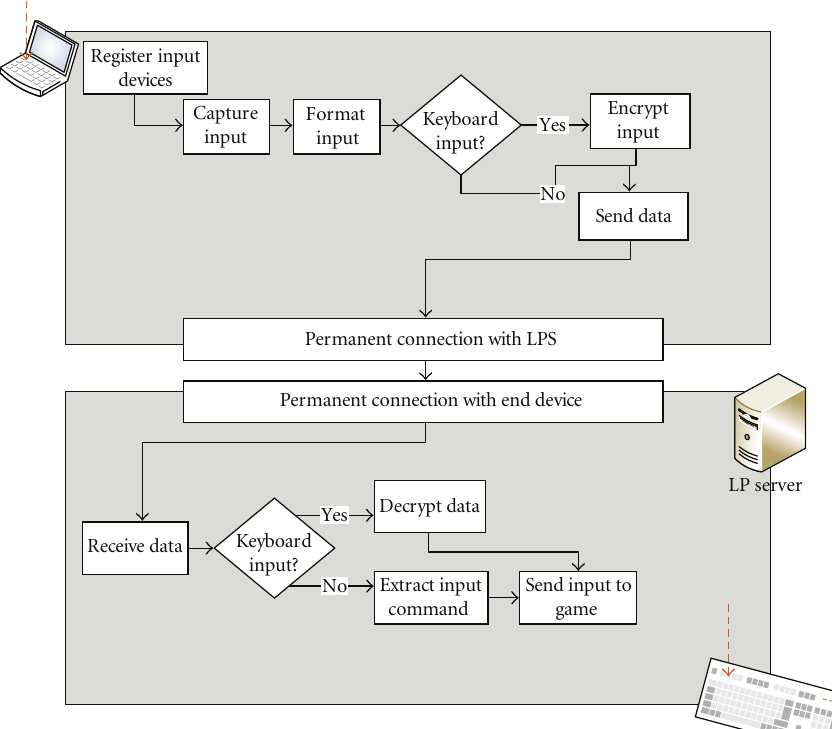
Figure 5: Encrypted command